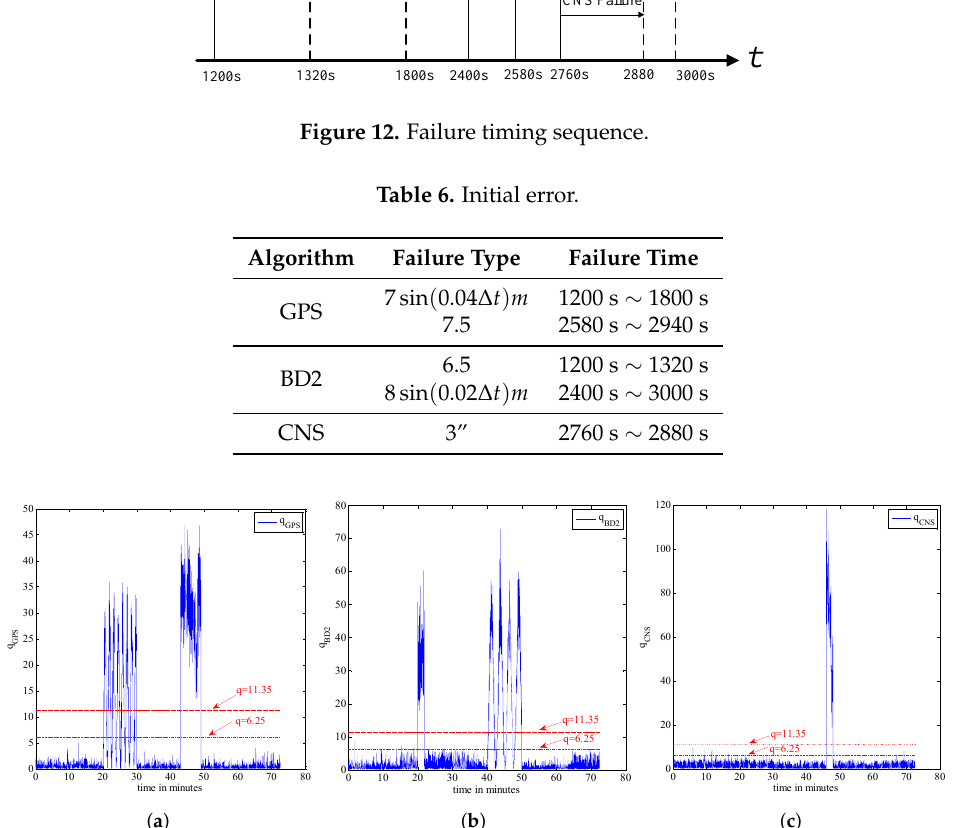
Figure 13. Failure detection ( a ) GPS failure; ( b ) GPS failure; ( c ) GPS failure.